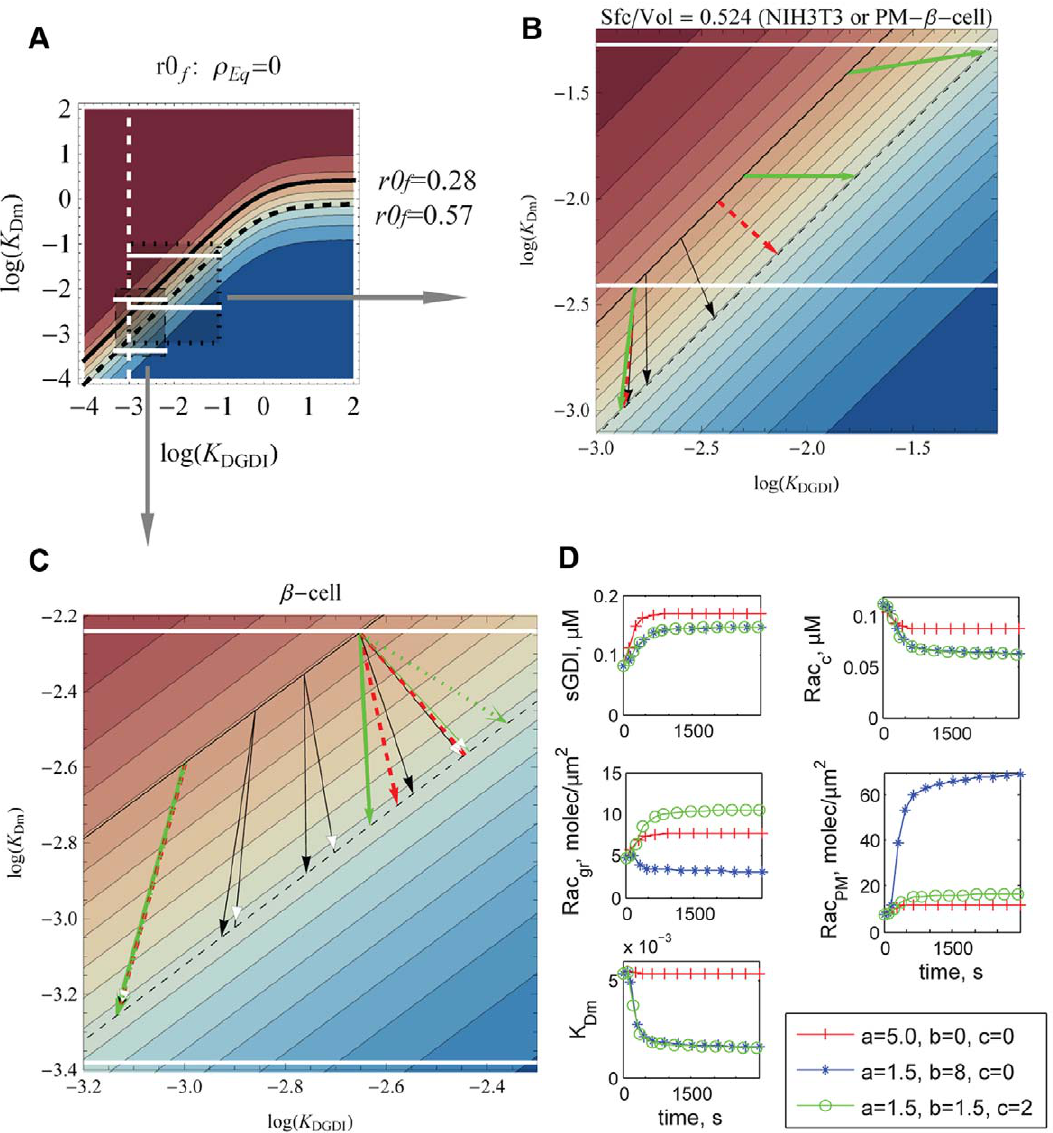
Figure 5. Membrane fraction of Rac before and after increase in sGDI due to stimulus. A–C. Horizontal lines delimit K Dm for minimum and maximum GEF/GAP based on values in Section Detailed model, for a cell with (B) Sfc/Vol=0.544/ m m, corresponding to NIH3T3 cells or the surface area of only the plasma membrane of b -cell, or (C) Sfc/Vol=4.8/ m m, corresponding to the surface area of both plasma and granular membranes of the b -cell. At time 0, r0 f =0.28 (solid bold curve), and at 20 minutes r0 f =0.57 (dashed black curve). Arrows represent effective trajectories that satisfy the 70% increase in sGDI and 40% decrease in cytosolic Rac. Arrow type for fold increase in dissociation constant between Rac and sGDI in comparison to unphosphorylated GDI (see text): 5, solid; 10, dashed; 100 (B) and 1000 (C), bold (solid and dotted). For solid arrowheads, GDI bound to Cdc42 was considered inert. White arrowheads consider the effect of phosphorylation of GDI bound to Cdc42. All arrows, 0.15 m M cytosolic Cdc42 bound to GDI, but for dotted, 0.25 m M. D) Transient translocation of Rac between cytosol (Rac c ), plasma (Rac PM ) and granular membranes (Rac gr ) due to change in K DGDI only (cross), plus increased affinity for plasma membrane (star, b . 0) and granular membrane (circle, c . 0).